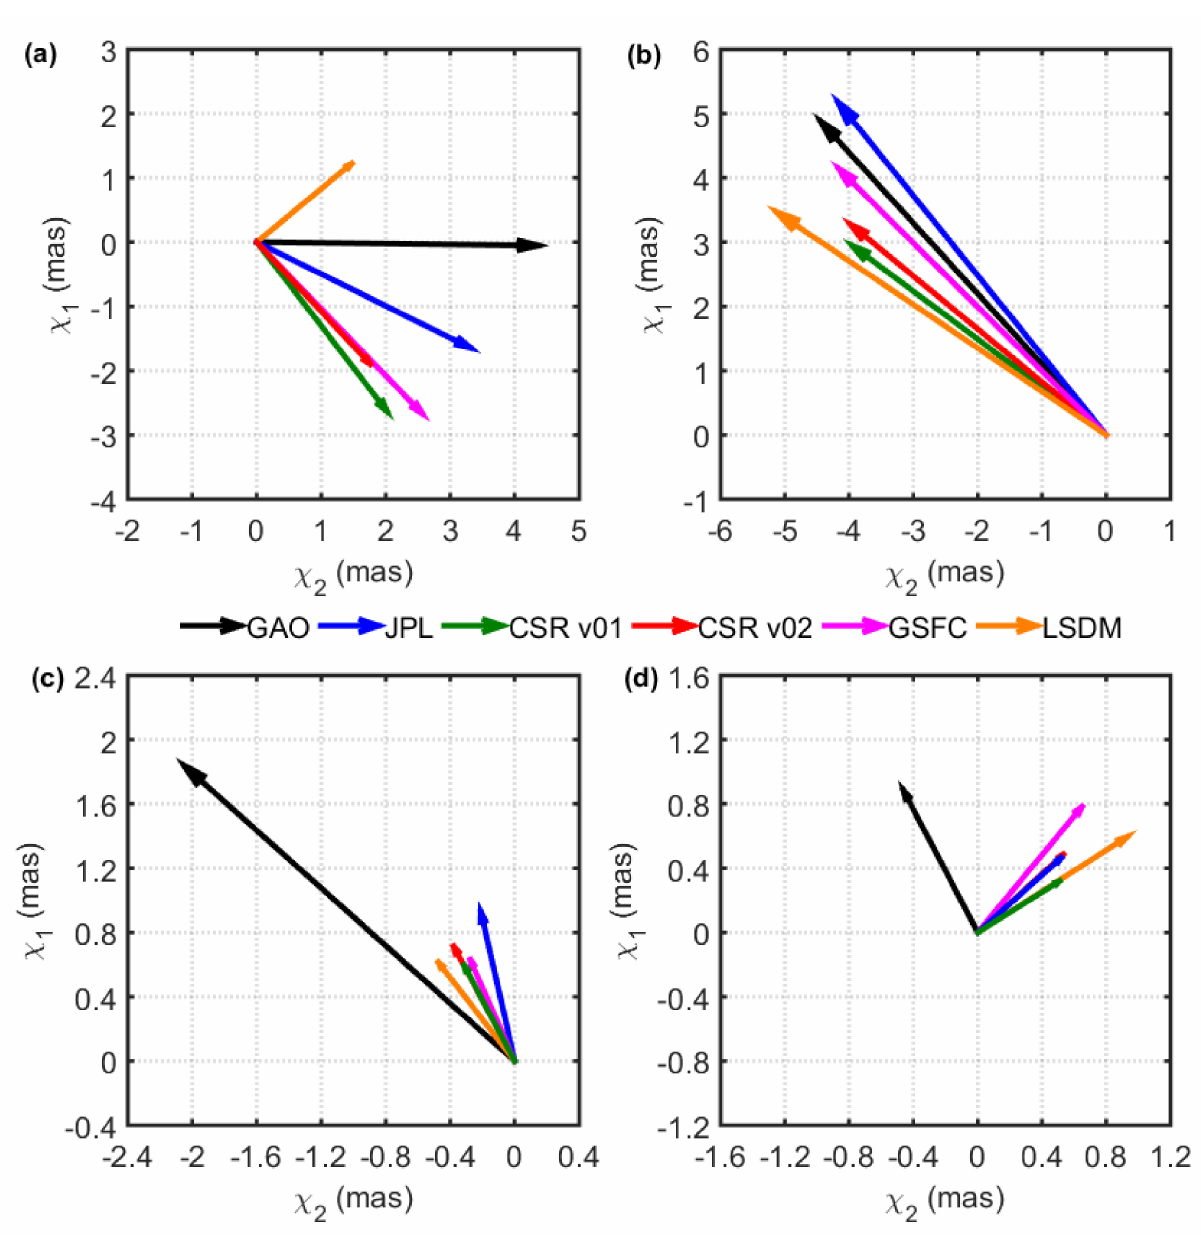
Figure 6. Phasor diagrams of ( a ) annual prograde, ( b ) annual retrograde, ( c ) semiannual prograde, and ( d ) semiannual retrograde variation in χ 1 + i χ 2 for GAO, GRACE-based HAM/CAM, and LSDM-based HAM. Phase ( φ ) in ( a , b ) is defined by the annual term as sin(2 π (t − t 0 ) + φ ), where t 0 is the reference epoch (1 January 2004). φ in ( c , d ) is defined by the semiannual term as sin(4 π (t − t 0 ) + φ